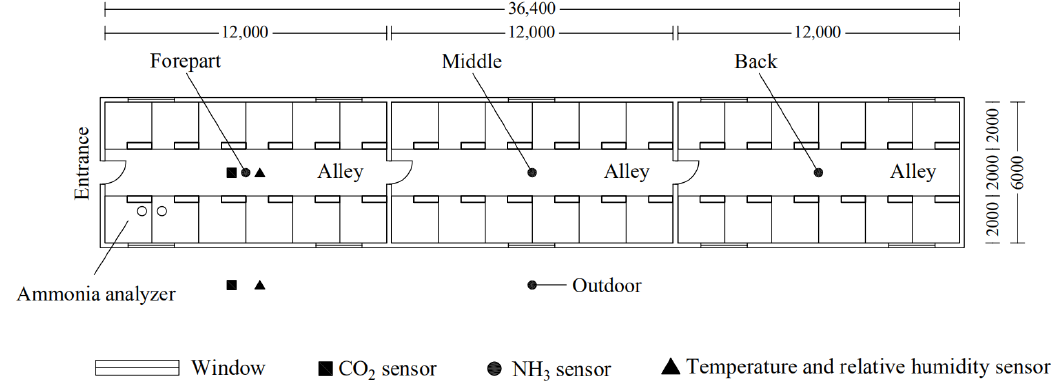
Figure 1. Structure of pig house and distribution of monitoring points.